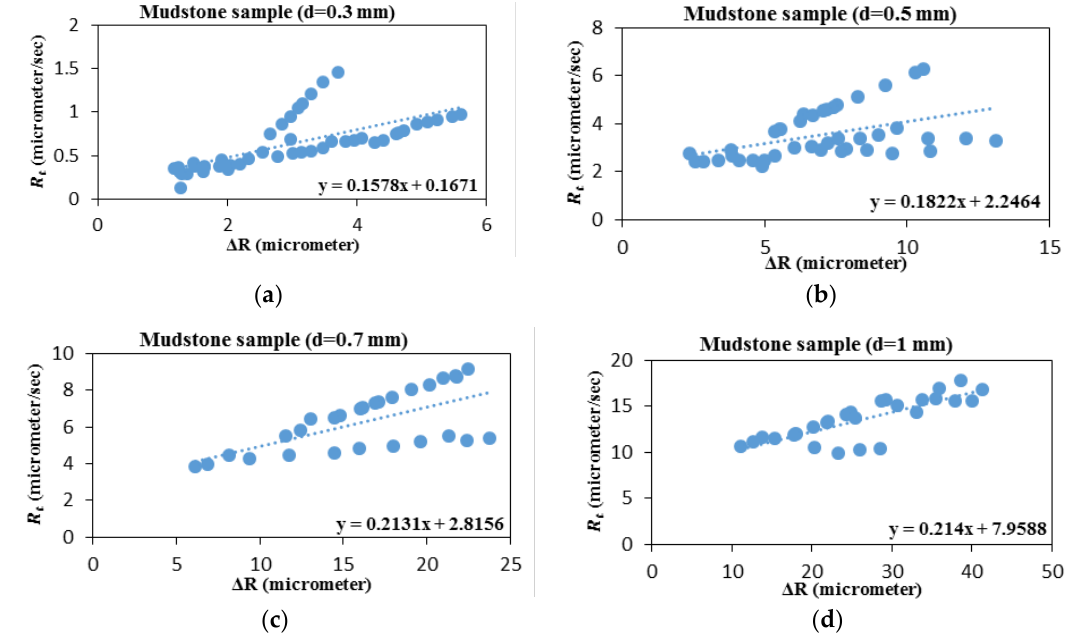
Figure 28. R t versus ∆ R evolution with rising DOC: ( a ) d = 0.3 mm; ( b ) d = 0.5 mm; ( c ) d = 0.7 mm; ( d ) d = 1 mm .